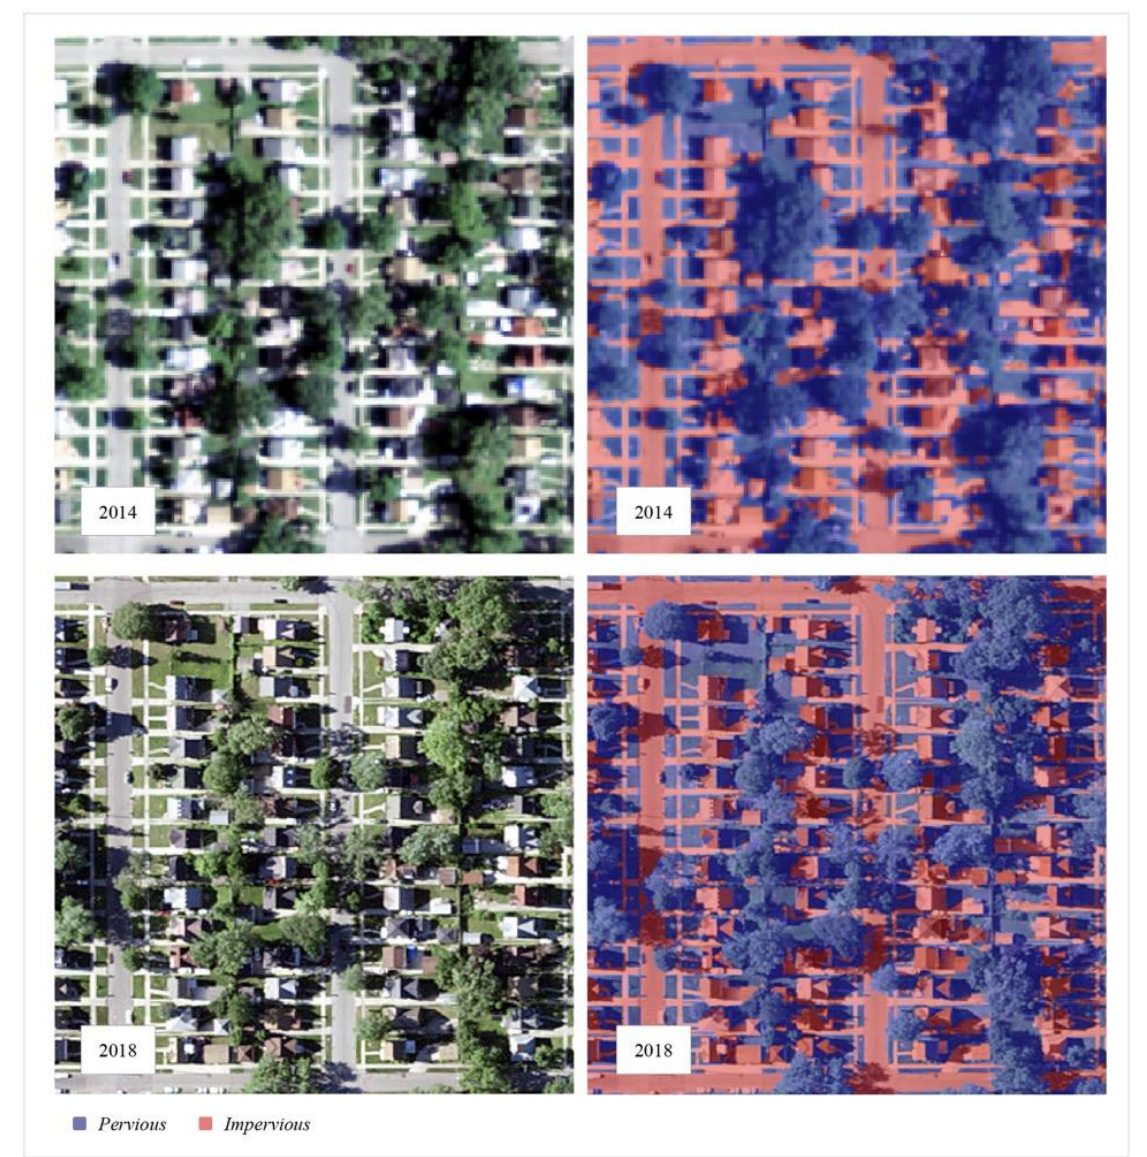
Figure 9. Batch GEOBIA, low demolition rate, Crary/St. Mary, Detroit. Four classes represent the change captured between the NAIP 2018 and 2014 imagery sets: (a) structure remained—parcel lot contained a structure in both data sets; (b) structure demolished—a structure existed in NAIP 2014, but an empty parcel lot in 2018; (c) remained empty—parcel lot is vacant in both imagery sets; (d) new structure—parcel lot did not contain a structure in 2014 and did contain a structure in 2018. According to the visual inspection of the NAIP imagery datasets, within the 2.59 square km (one square mile) tile extent, 66 (2.78%) demolitions occurred. In Crary/St. Mary (low rate), 32 (0.94%) occurred. In Core City (median rate), 35 (2.37%) occurred. In Pulaski (high rate), 295 (11.61%) occurred. Figure 12 maps the three areas of interest and Table 7 describes the number of parcel lots within each